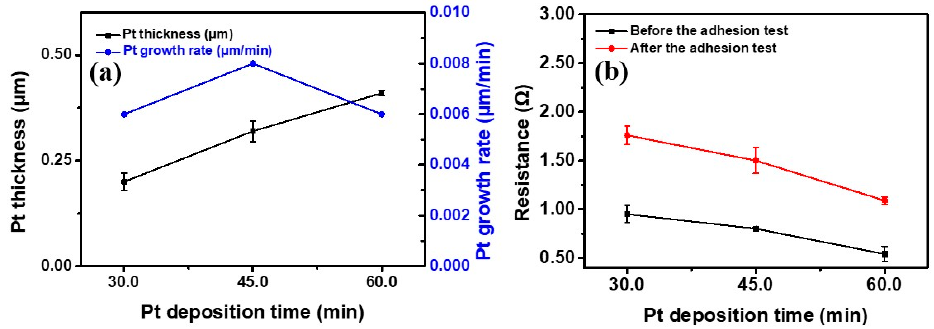
Figure 4. Plots of the ( a ) Pt deposition time versus the Pt layer thickness and the Pt growth rate, and the ( b ) Pt deposition time versus the electrical